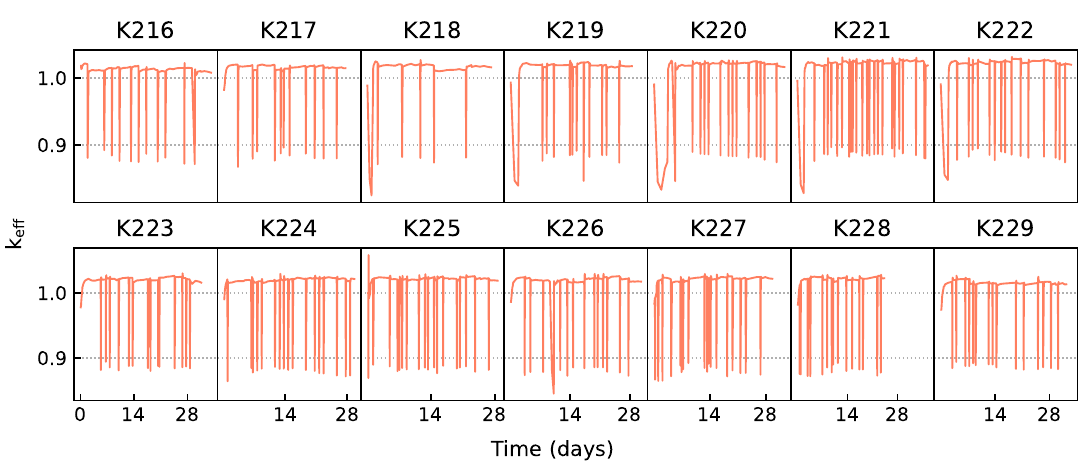
Figure 3. Development of k eff calculated with Serpent throughout cycles K216–K229.